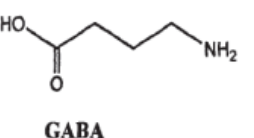
Figure 1. Molecular structure of gamma-aminobutyric acid (GABA).